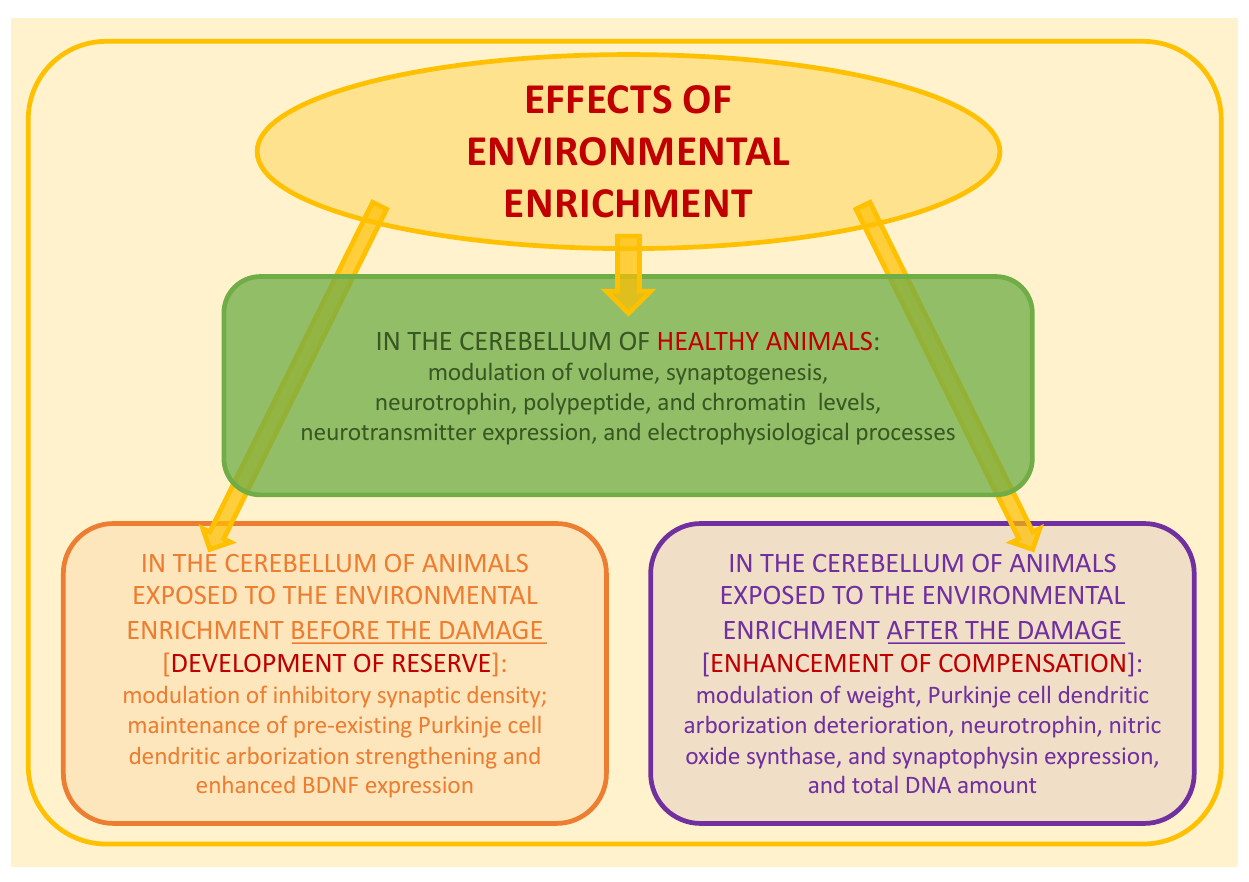
Figure 2. The panel synthesizes the evidence provided by animal models on the effects of environ- mental enrichment exposure on the cerebellum, taking into account the studies on healthy subjects (box in the middle) and on animals exposed to EE before (box at the bottom on the left side) and after (box at the bottom on the right side) a damage involving cerebellar functionality. BDNF: brain-derived neurotrophic factor; DNA: deoxyribonucleic